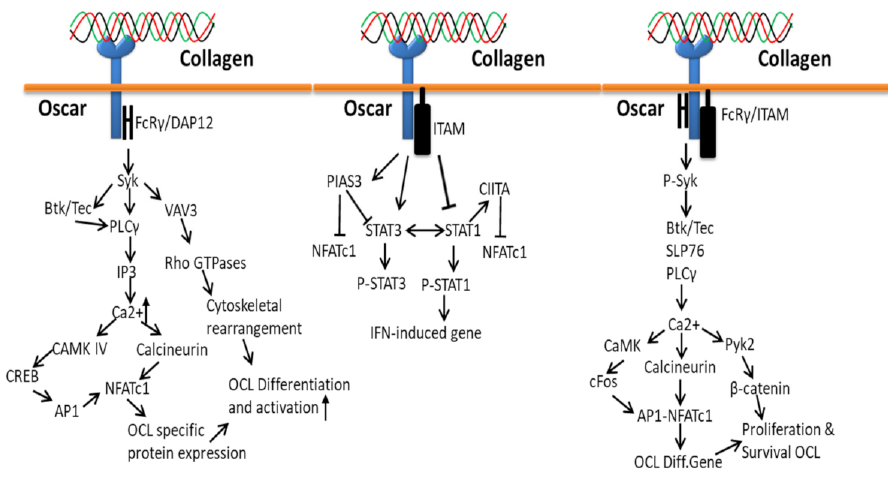
Figure 9. Collagen Oscar signals in